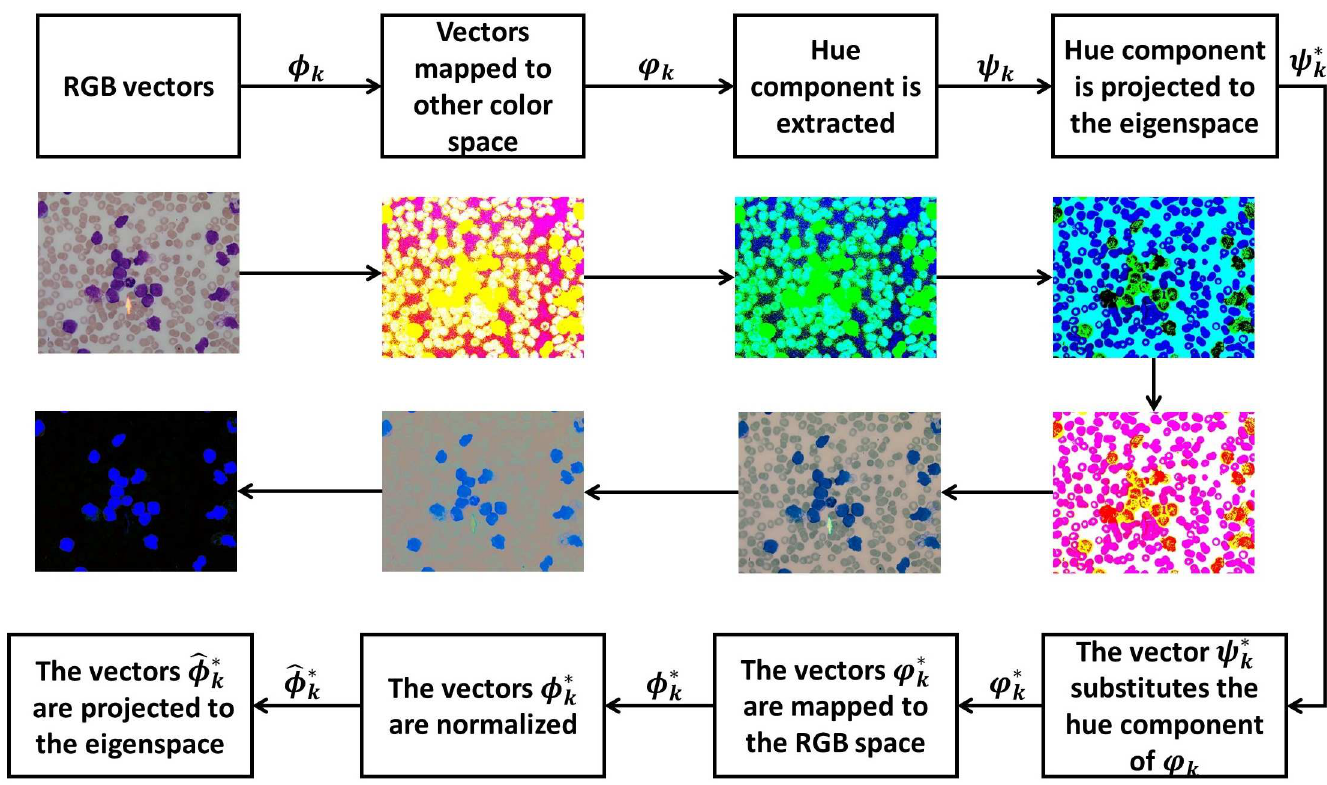
Fig 2. Flow chart of proposed segmentation methodology: To maximize the chromatic variance of the pixels, the WBCs are segmented by color features on a set of projections of the chromaticity components. First, the RGB colors of the given image are mapped to the (different) color space HSV and L � a � b � spaces; then, the hue components of colors are extracted to form the vectors ψ projected vectors substitute the hue components of the vectors φ k , obtaining the vectors φ � normalized and their PCs computed. Finally, the normalized vectors are projected to the eigenspace, obtaining the color vectors that shape the WBCs.